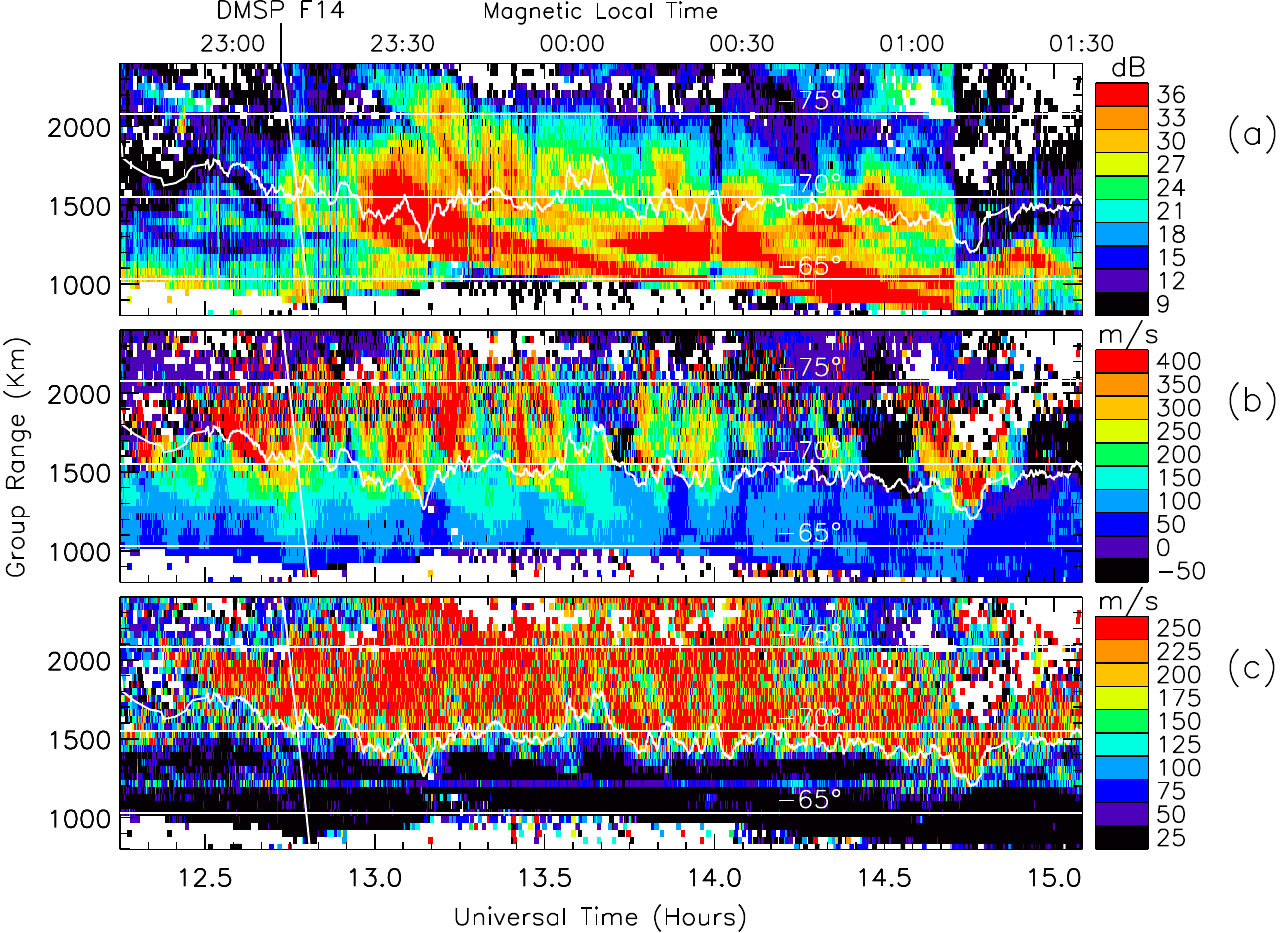
Fig. 3. RTI plots of (a) TIGER backscatter power (dB), (b) LOS Doppler velocity (m/s), and (c) spectral width (m/s) recorded on beam 4 during 12:15 to 15:00UT, 10 December 1999. The spectral width boundary (SWB) was automatically identified (as explained in the text) and has been superimposed in all panels. The three thin, white horizontal lines in all panels correspond to AACGM latitudes of − 65 ◦ (MQI), − 70 ◦ , and − 75 ◦ . Diagonal white lines starting at 12:45UT in all three panels represent the transit of the DMSP F14 satellite (cf., Fig. 2). The patchy horizontal line in the data samples at range 1215km in (c) corresponds to a bad range in the autocorrelation function. The abscissas have tick marks at 5min intervals of UT, and nominal values of MLT separated by 30min intervals are included at